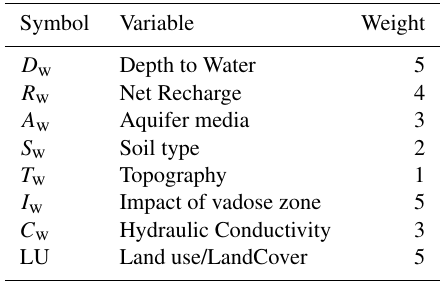
Table 1. Weight settings for DRASTIC variables (Aller et al.,